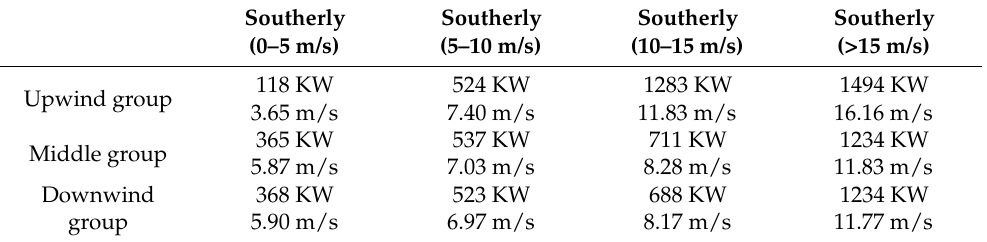
Figure 4. ( a – d ) show the distribution of wind power of the Gobi grassland wind farm in groups of 0–5 m/s, 5–10 m/s, 10–15 m/s, and >15 m/s. Table 2. Statistics for the average generated power and wind speed of upwind, middle, and down- wind groups in different southerly ranges of 0–5 m/s, 5–10 m/s, 10–15 m/s, and >15